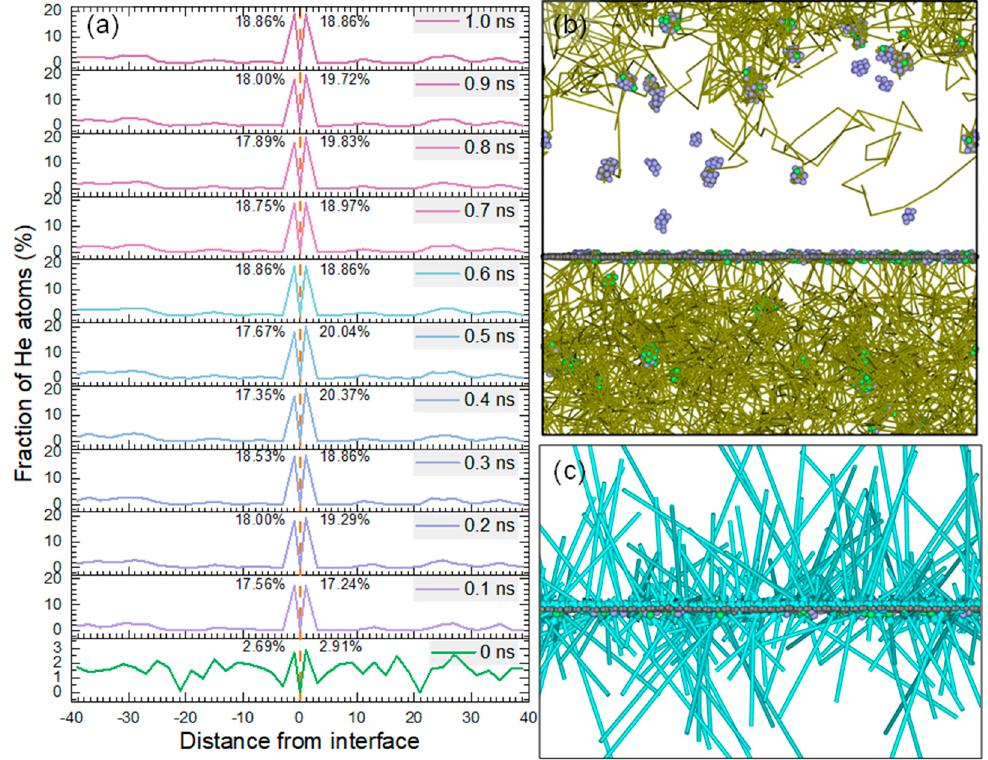
Figure 10. Statistics of He diffusion at defective NGI. ( a ) Fractions of He atoms as a function of the distance from the NGI. ( b ) He diffusion trajectories during 1.0 ns. For presentation purposes, only the trajectories of He atoms initially located below the interface are plotted. ( c ) Displacements of He atoms near the NGI, shown by the turquoise displacement vectors between their initial and final